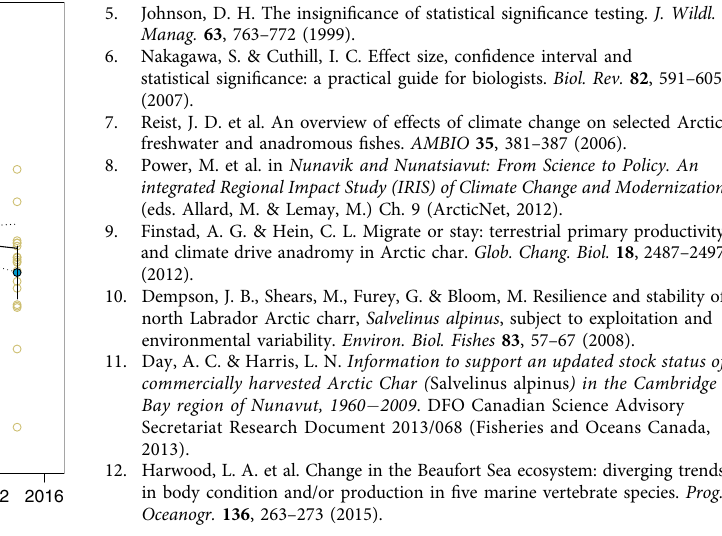
Fig. 1 Fulton ’ s condition factor of Arctic Char collected between 1981 and 2014 from Lake Hazen. Open circles correspond to the condition factor of individuals, whereas solid blue circles are annual averages± 1 SE. The solid line shows predictions from a quadratic regression of annual averages with 95% con fi dence intervals ( p =